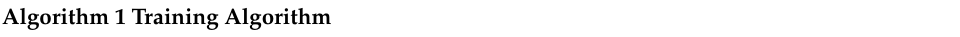
Algorithm 1 Training